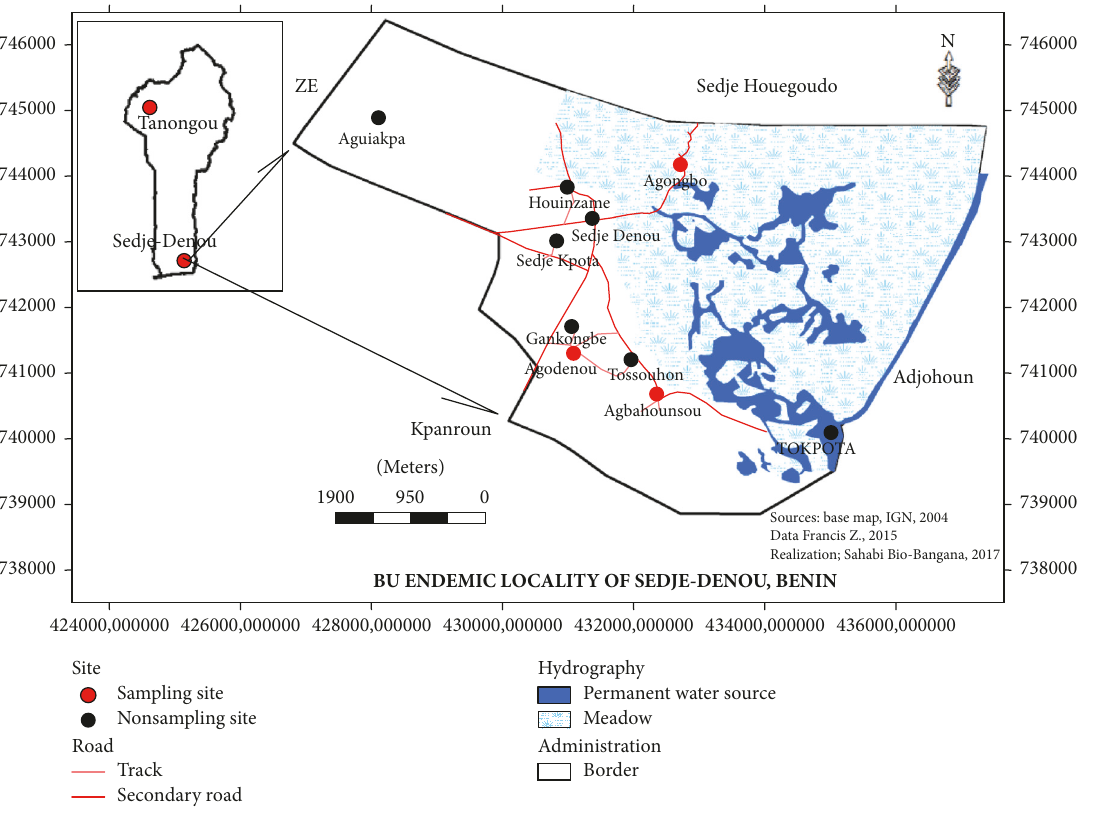
Figure 1: Location map of study sites in the Buruli ulcer endemic area in Southern Benin and the nonendemic area in Northern